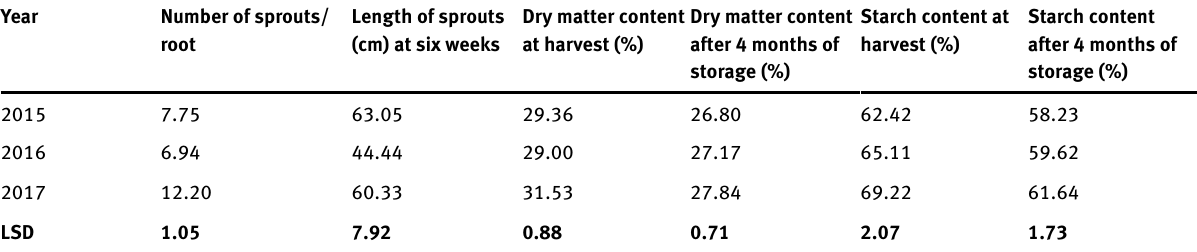
Table 5: Effect of years on means of number of sprouts per genotype, length of sprouts measured at six weeks after sprouting (cm), dry matter content at harvest and four months after storage (%), starch content at harvest and four months after storage (%) from analysed data collected at Umbeluzi Research Station and Nwalate Farm in 2015, 2016 and 2017